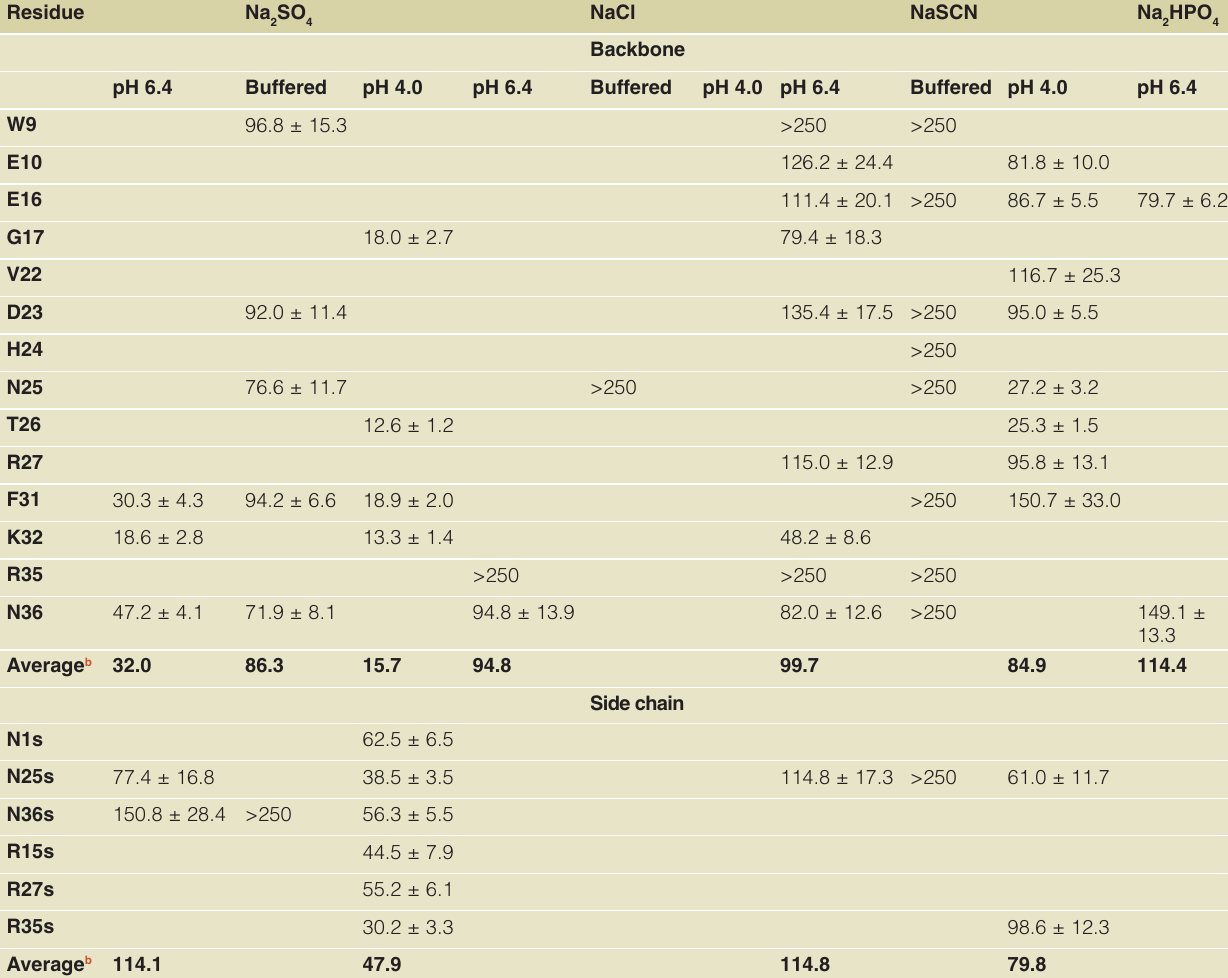
Table 1. Apparent Dissociation Constants (Kd) for Binding of Salts to WW4 Domain a,b,c .